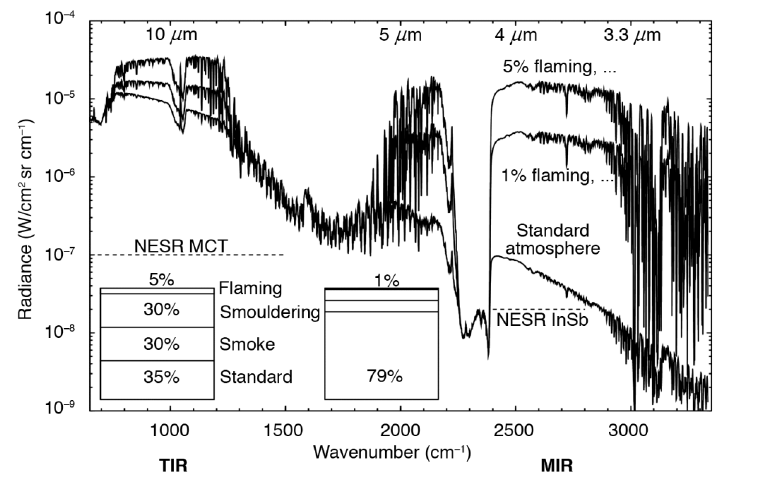
Fig. 7. Radiance spectra calculated for an undisturbed atmosphere and two different compositions of the spec- trometer footprint as indicated.